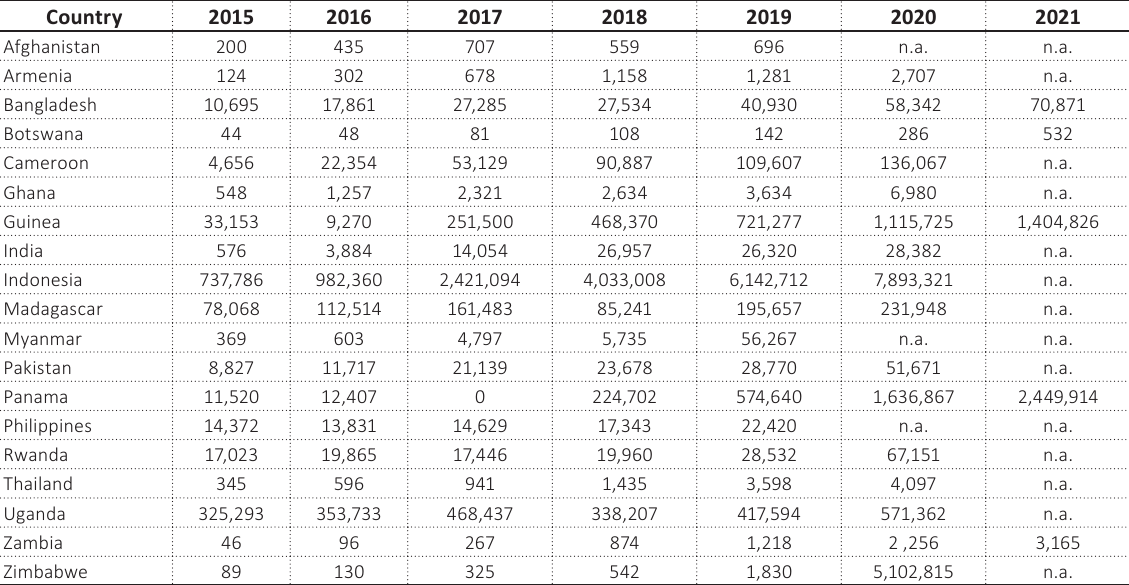
Table 3. The total amount of outstanding balances on active mobile money accounts in 2015–2021 (in millions of national